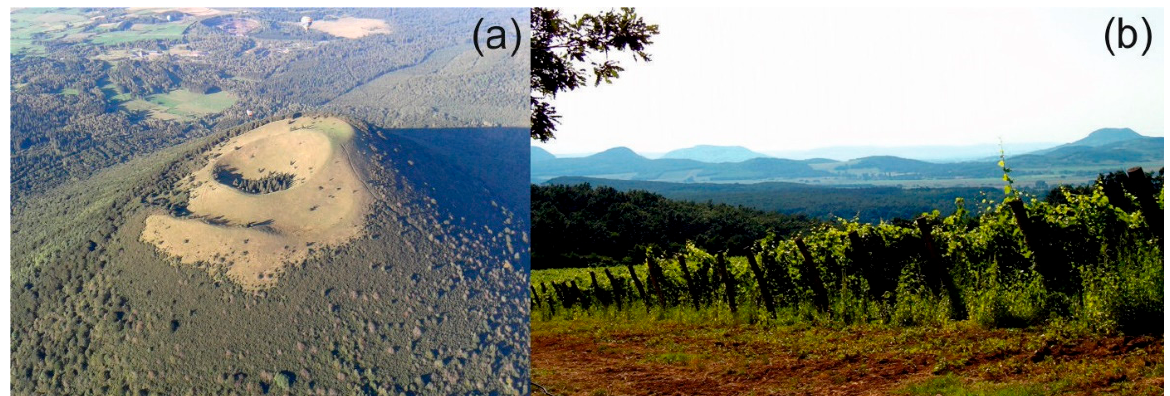
Figure 1. ( a ) A simple, regular scoria cone: Puy de Côme in Chaîne des Puys, Auvergne, France. ( b ) View of Balaton Uplands, Hungary: vineyards planted on the slopes of Pleistocene scoria cones. Source: [6]. Volcanic edifices (stratovolcanoes, scoria cones and other volcanic structures) are often considered as landmarks, and iconic features. In certain countries where active or dormant volcanoes characterize the area (e.g., in Japan, Indonesia, and South America), it is clear